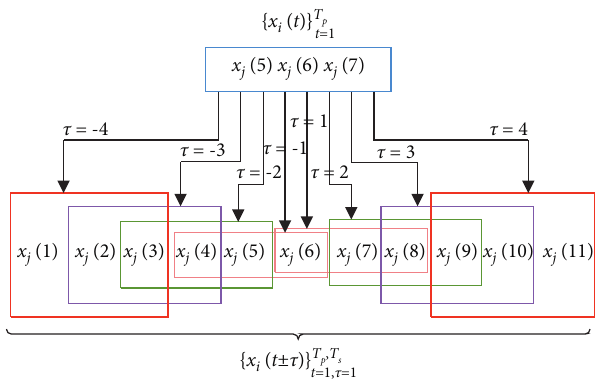
Figure 2: Example of sliding window data compression processing.